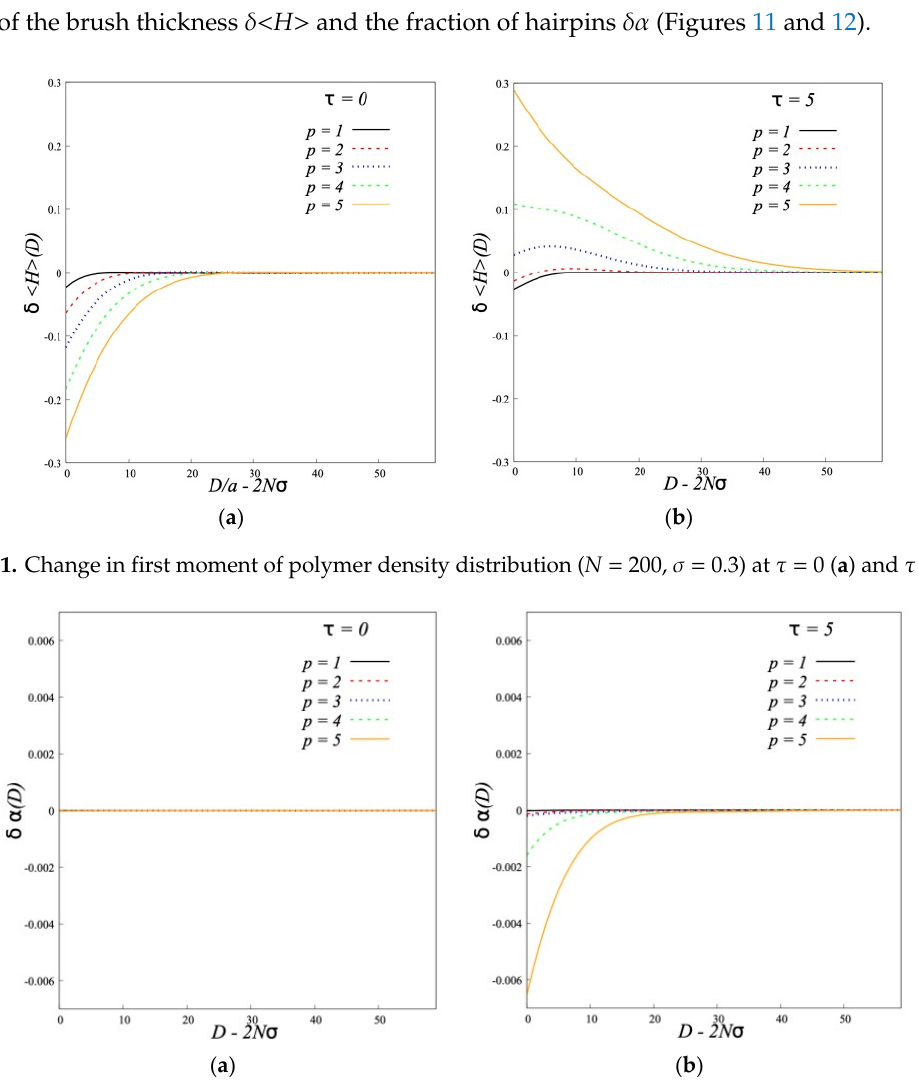
Figure 12. Change in fraction of backfolded chains ( N = 200, σ = 0.3) at τ = 0 ( a ) and τ = 5 ( b ).